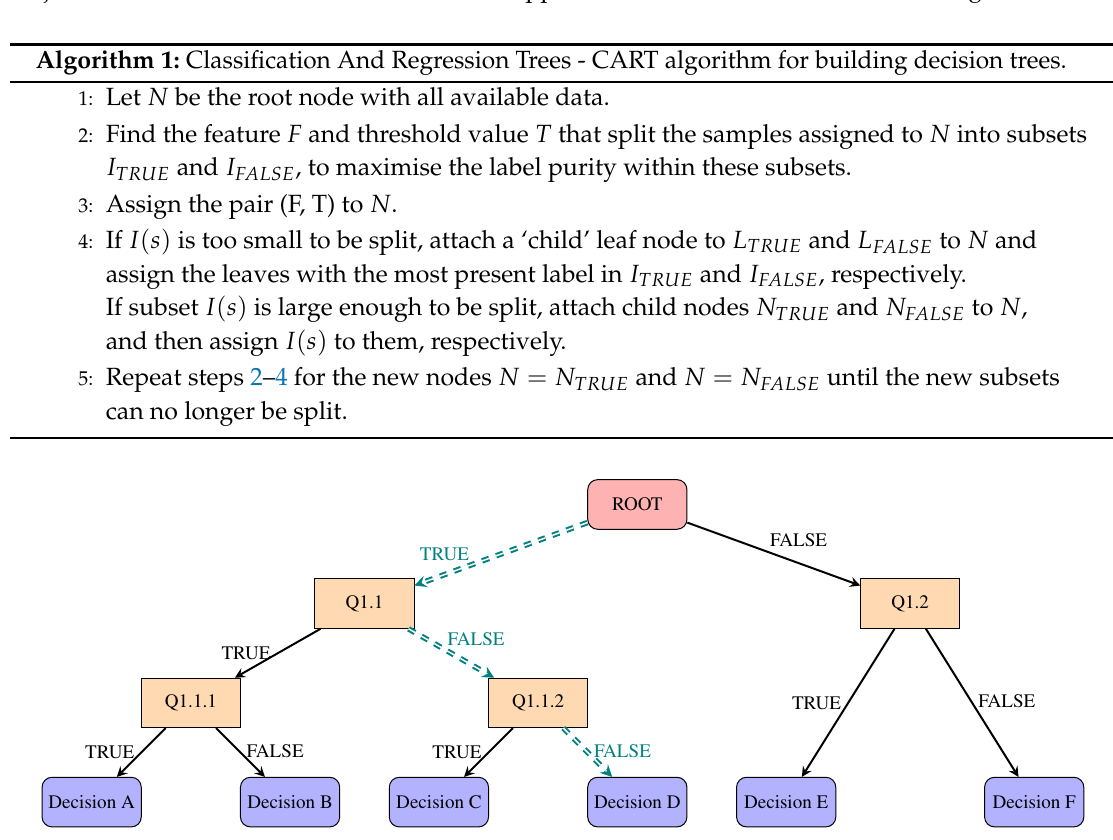
Algorithm 1 CART algorithm for building decision trees.